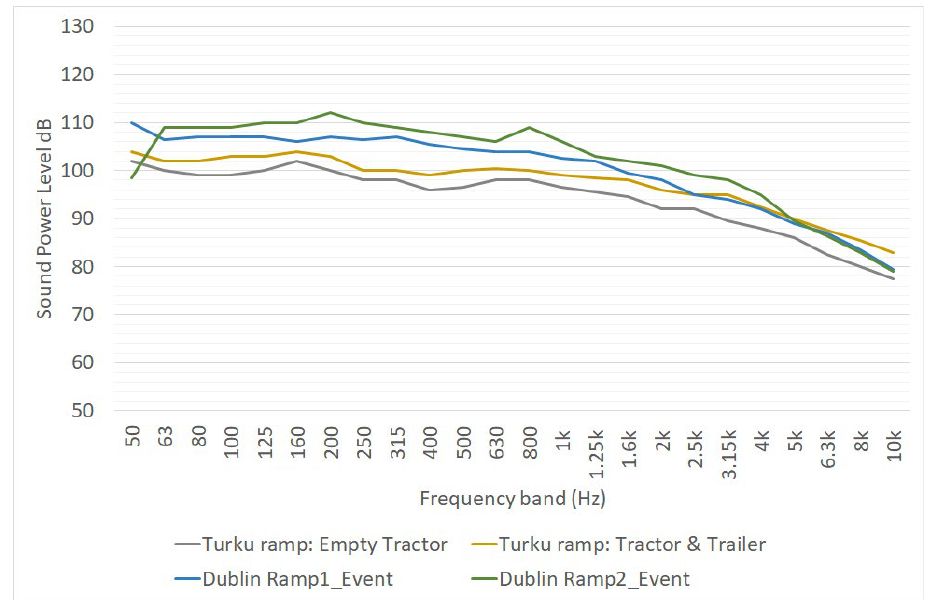
Figure 11. One-third octave sound power spectra of Ro-Ro ramps, as reported in deliverable 2.4.3 of [18]. L W is expressed in dB for point sources.